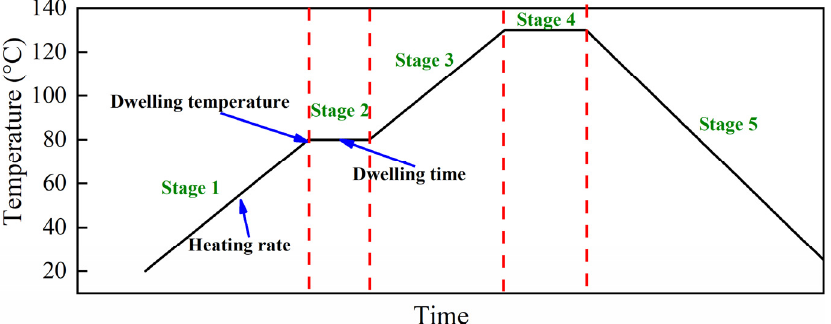
Figure 7. New curing cycle.